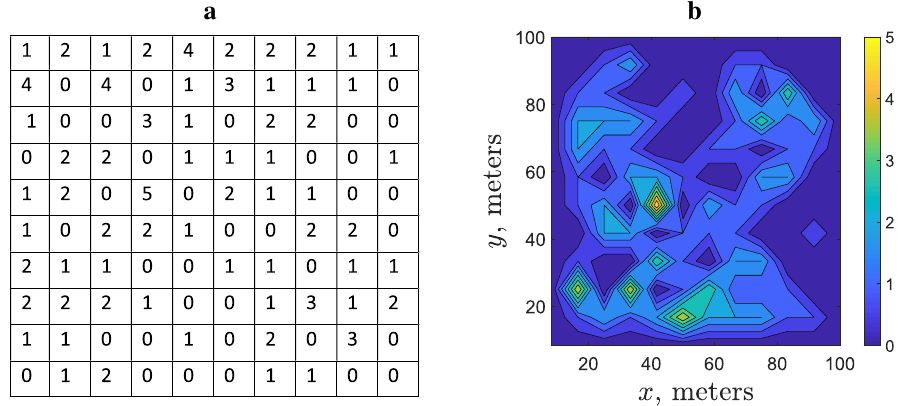
Figure 1. Example of a heterogeneous slug distribution. ( a ) Trap counts on the grid of traps recorded on 02 September 2016 in a crop field in Shropshire UK (see 18 for full details), and ( b ) a proxy of the corresponding density distribution reconstructed from the trap counts using linear